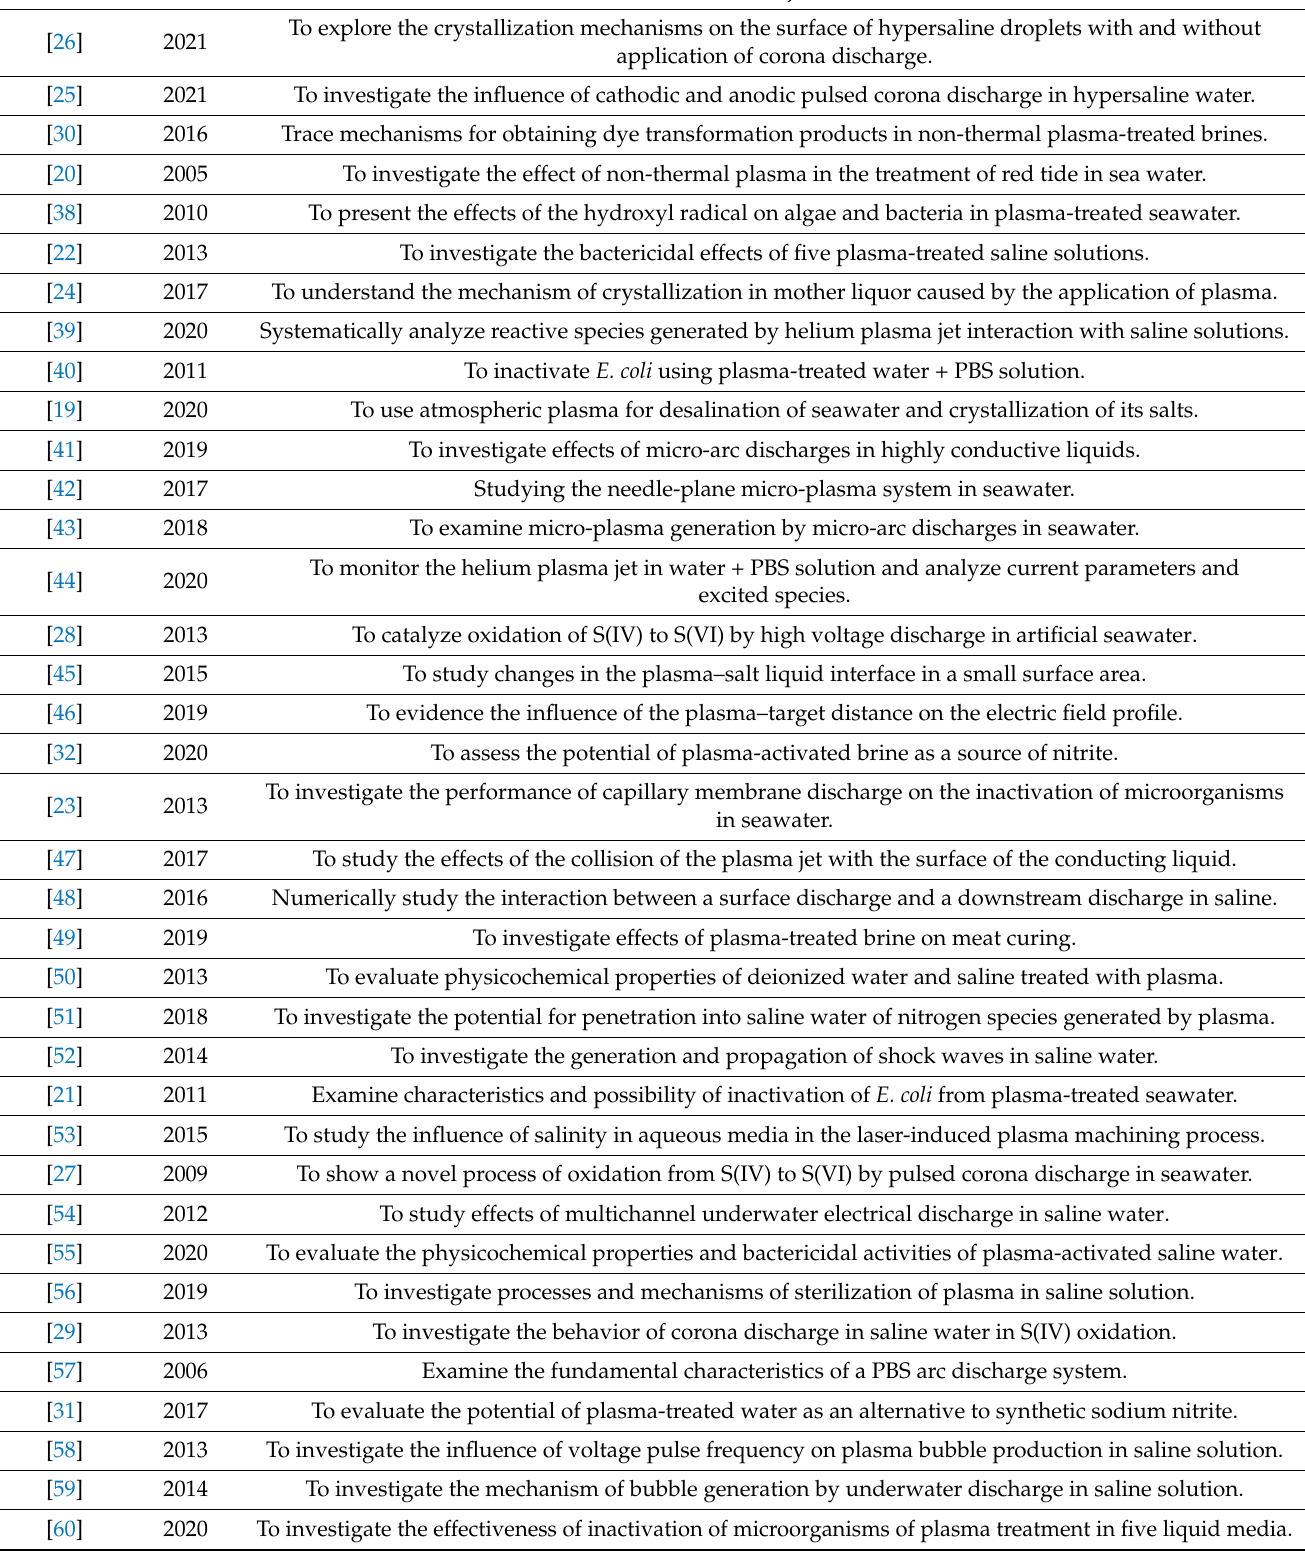
Table 1. List of articles included in the